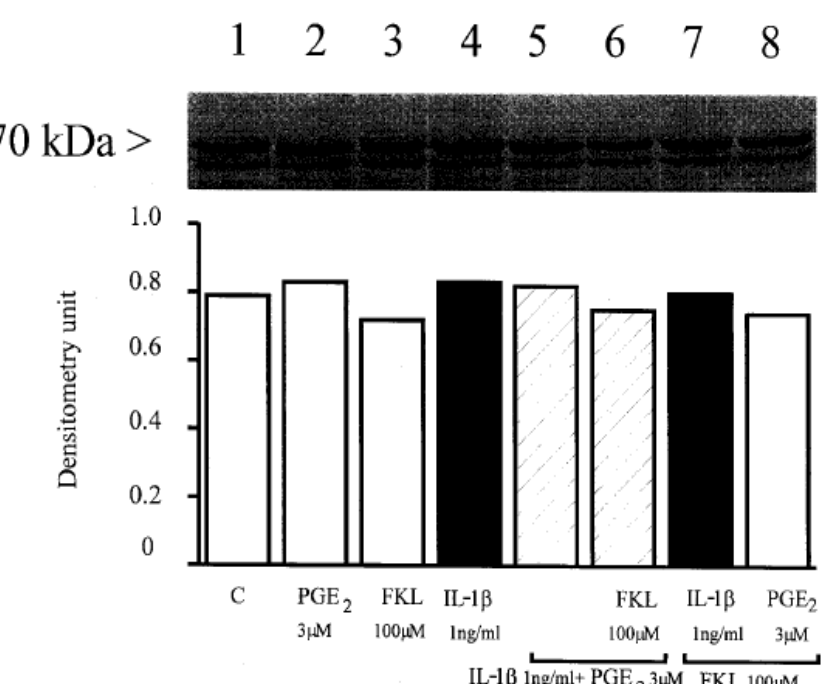
FIG. 7. The effects of forskolin on COX-1 protein expressed in IL-1 b (1ng/ml) plus PGE 2 (3 m M) treated HUVEC. COX-1 protein was detected by Western blots using polyclonal antibodies to COX-1 in cell extracts of HUVEC treated with no addition (lane 1), PGE 2 (3 m M; lane 2) alone, forskolin (100 m M; lane 3) alone, IL-1 b (1ng/ml; lane 4) alone, IL-1 b (1ng/ml) plus PGE 2 (3 m M; lane 5), IL-1 b (1ng/ml) plus PGE 2 (3 m M) with forskolin (100 m M; lane 6), IL-1 b (1ng/ml) plus forskolin (100 m M; lane 7) or PGE 2 (3 m M) plus forskolin (100 m M; lane 8) for 24h. Equal amounts of protein (20 m g/lane) were loaded in each lanes. Similar results were obtained with cell extracts from three separate batches of cells. The significant differences between each band were compared by scanner densitometry using image 1D program (densitometry